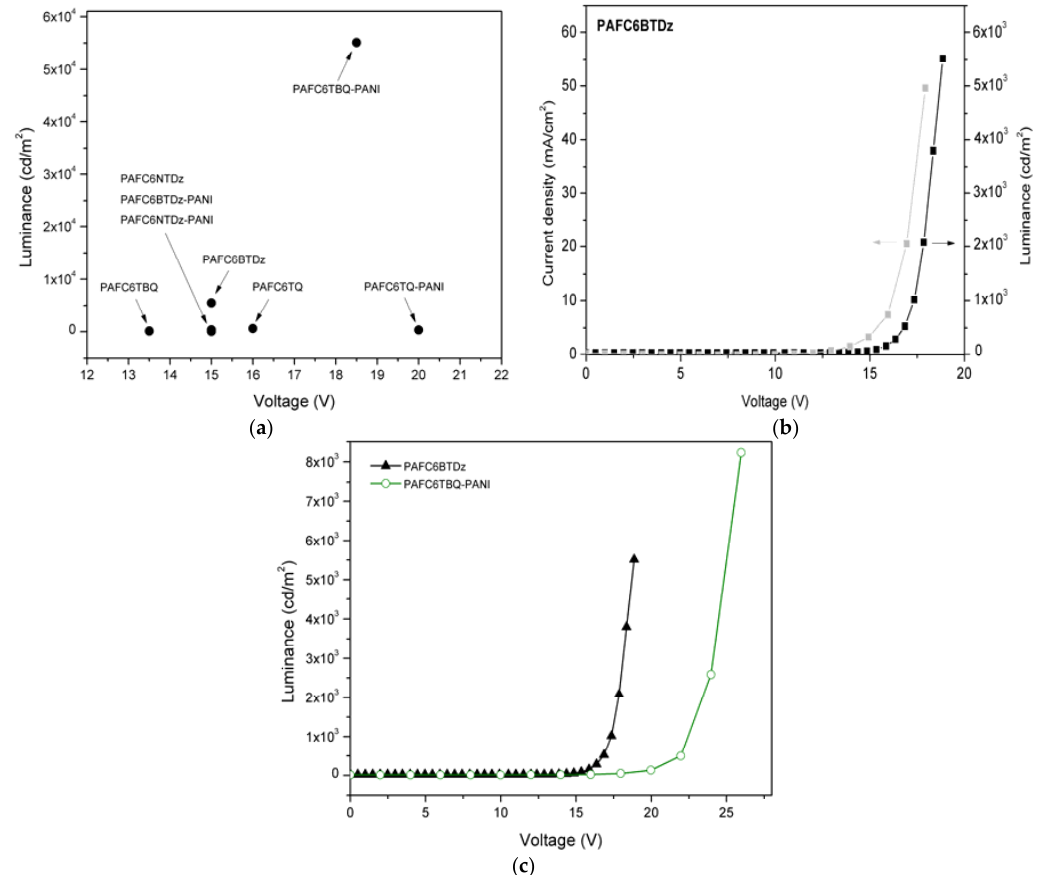
Figure 6. Device characteristics of the conducting polymer (CP) ‐ based OLEDs with the configuration of glass/ITO/MoO 3 (3 nm)/polymer (50–60 nm)/C 60 (40 nm)/bathocuproine (BCP) (10 nm)/Al (100 nm). ( a ) Luminance ‐ voltage values for the best performing devices with 1D ‐ and 2D ‐ CPs as emissive layers. ( b ) Current density ‐ voltage ‐ luminance plot of the PAFC6BTDz ‐ based device. ( c ) Luminance ‐ voltage characteristics of the PAFC6BTDz and PAFC6TBQ ‐ PANI as emitting CPs.